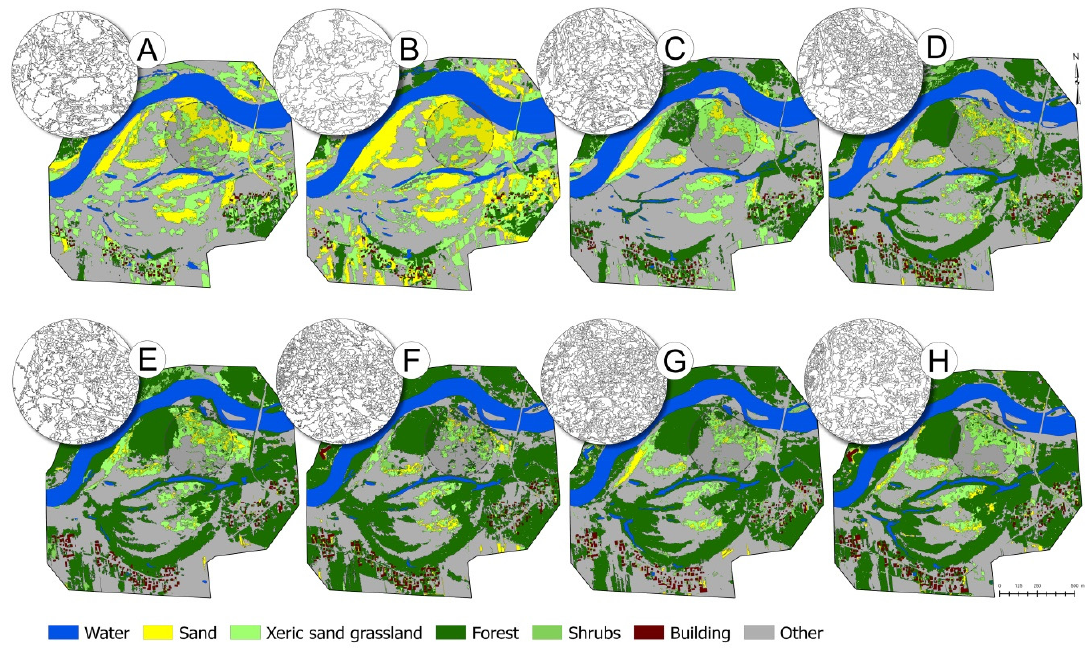
Figure 7. The segments (round frames) and the segment classification results (land-cover map): ( A ) 1957, ( B ) 1965, ( C ) 1973, ( D ) 1997, ( E ) 2006, ( F ) 2010, ( G ) 2015, and ( H ) 2018.